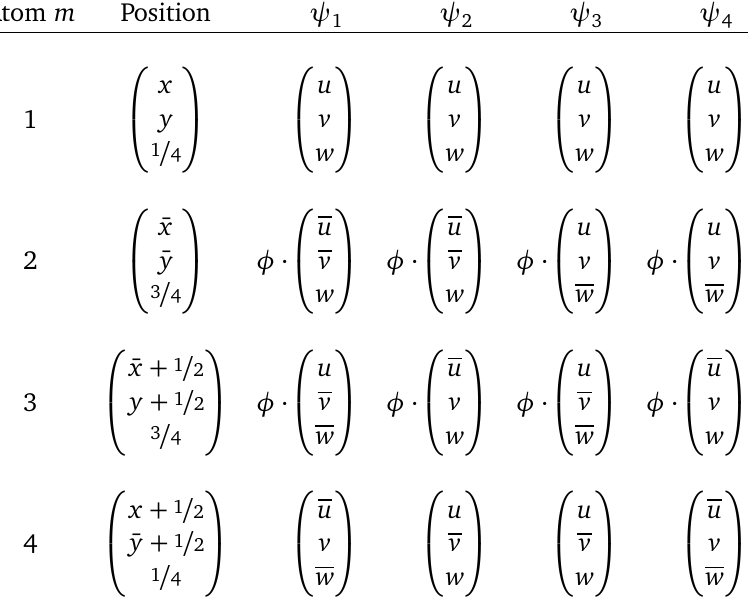
for the Er n have been Γ n